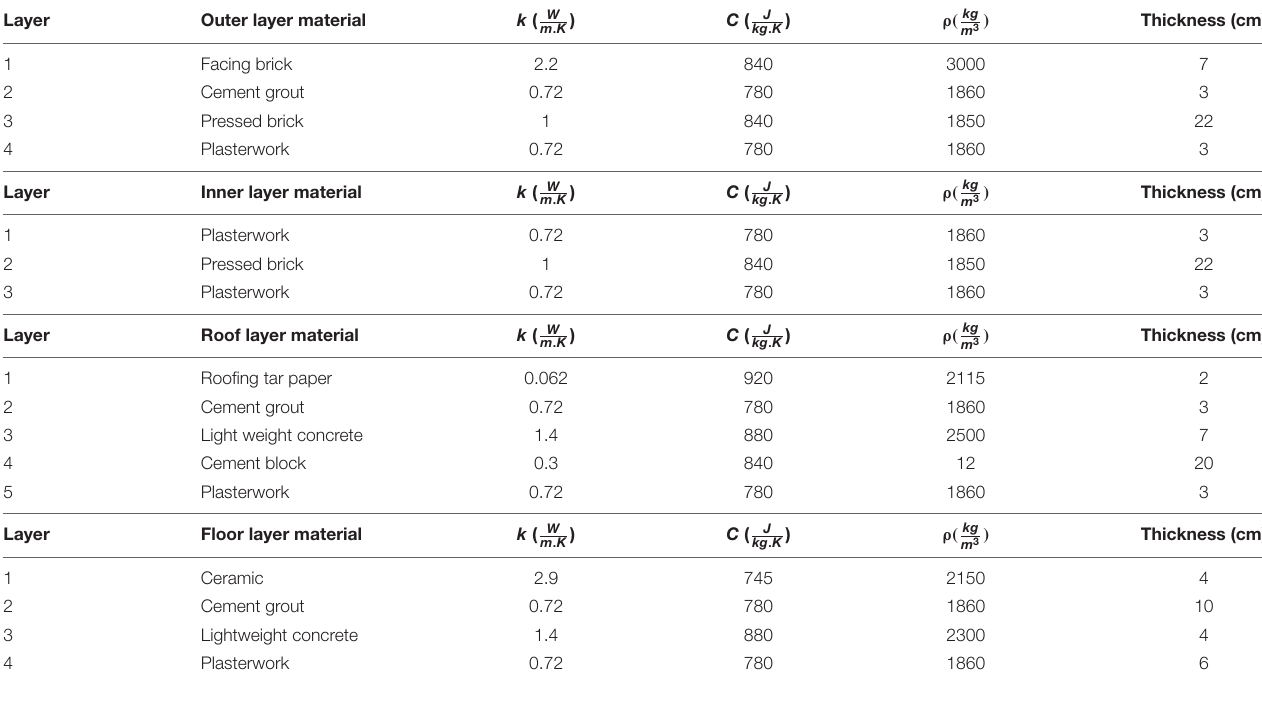
TABLE 4 | Thermal and physical properties of outer wall